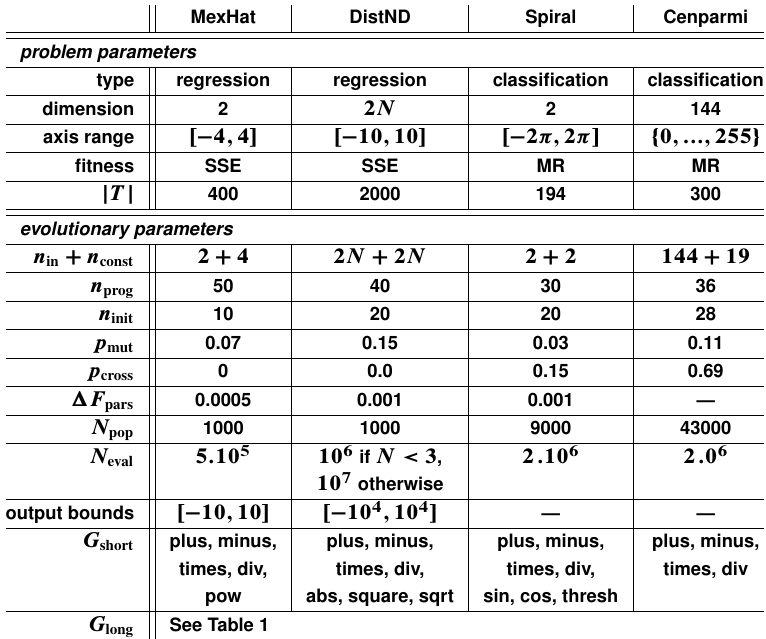
Table 2. Summary of the three benchmark problems and their associated parameters. MexHat DistND Spiral Cenparmi problem parameters type regression regression classification classification